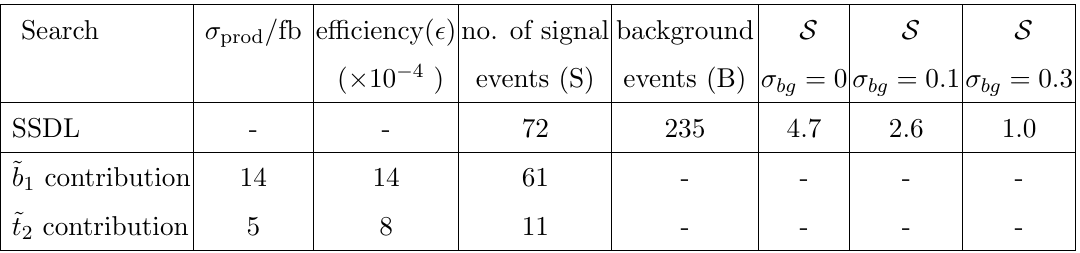
Table 2 . Same-sign dilepton analysis: e(cid:14)ciency of cuts, number of events, and signi(cid:12)cance of signal with 3000/fb of data at the 13 TeV LHC. We have de(cid:12)ned S (cid:17) S = for